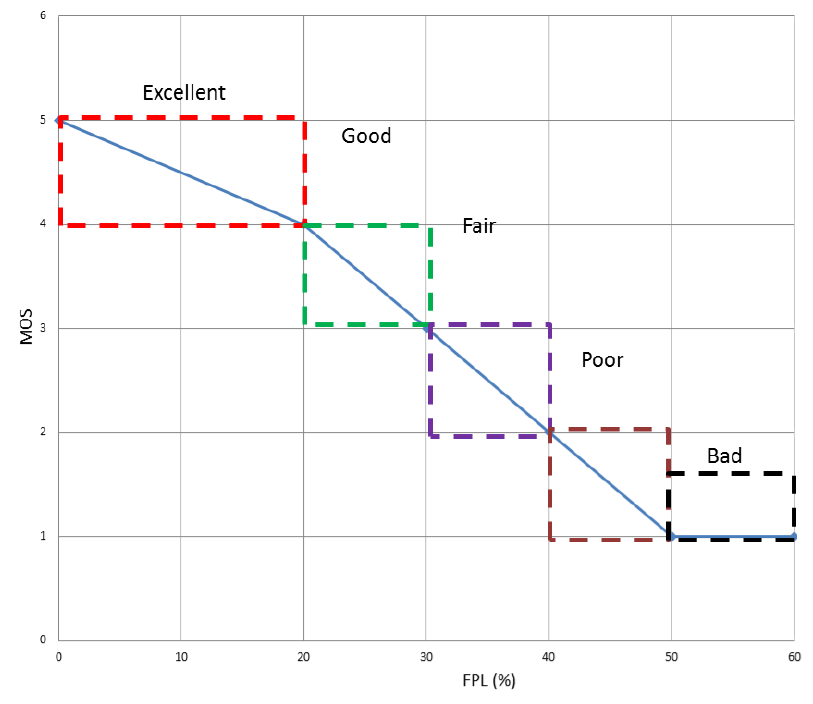
Figure 6. Subjective video quality measured by means of the mean opinion score (MOS) as a function of the fraction of packet losses